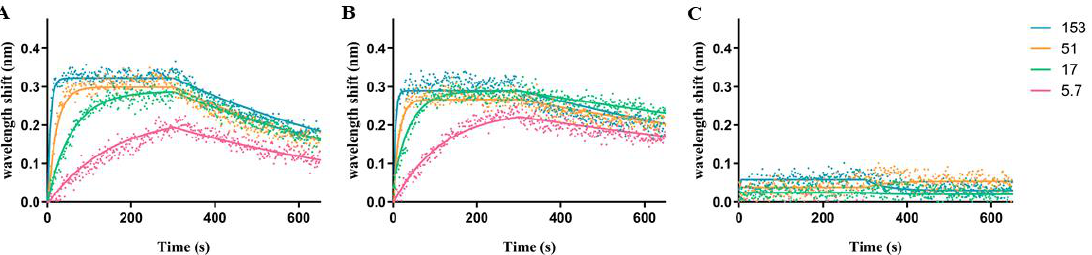
Figure 4. Representative BLI association and dissociation data plots. Graphs depict raw association and dissociation step data measured during BLI experiments with ( A ) ST2_1359_wt DNA, the wild-type TTHA1359 consensus sequence; ( B ) ST2_CRP_Ec DNA, the E. coli CRP consensus sequence; and ( C ) ST2_1359_ctrl DNA, the REPSAis control sequence. Dots depict raw data points. Solid lines depict calculated best-fit lines for raw data points. Line colors pink, green, orange, and cyan correspond to 5.7, 17, 51, and 153 nM dimeric TTHA1359, respectively. Table 1. TTHA1359-DNA binding parameters.